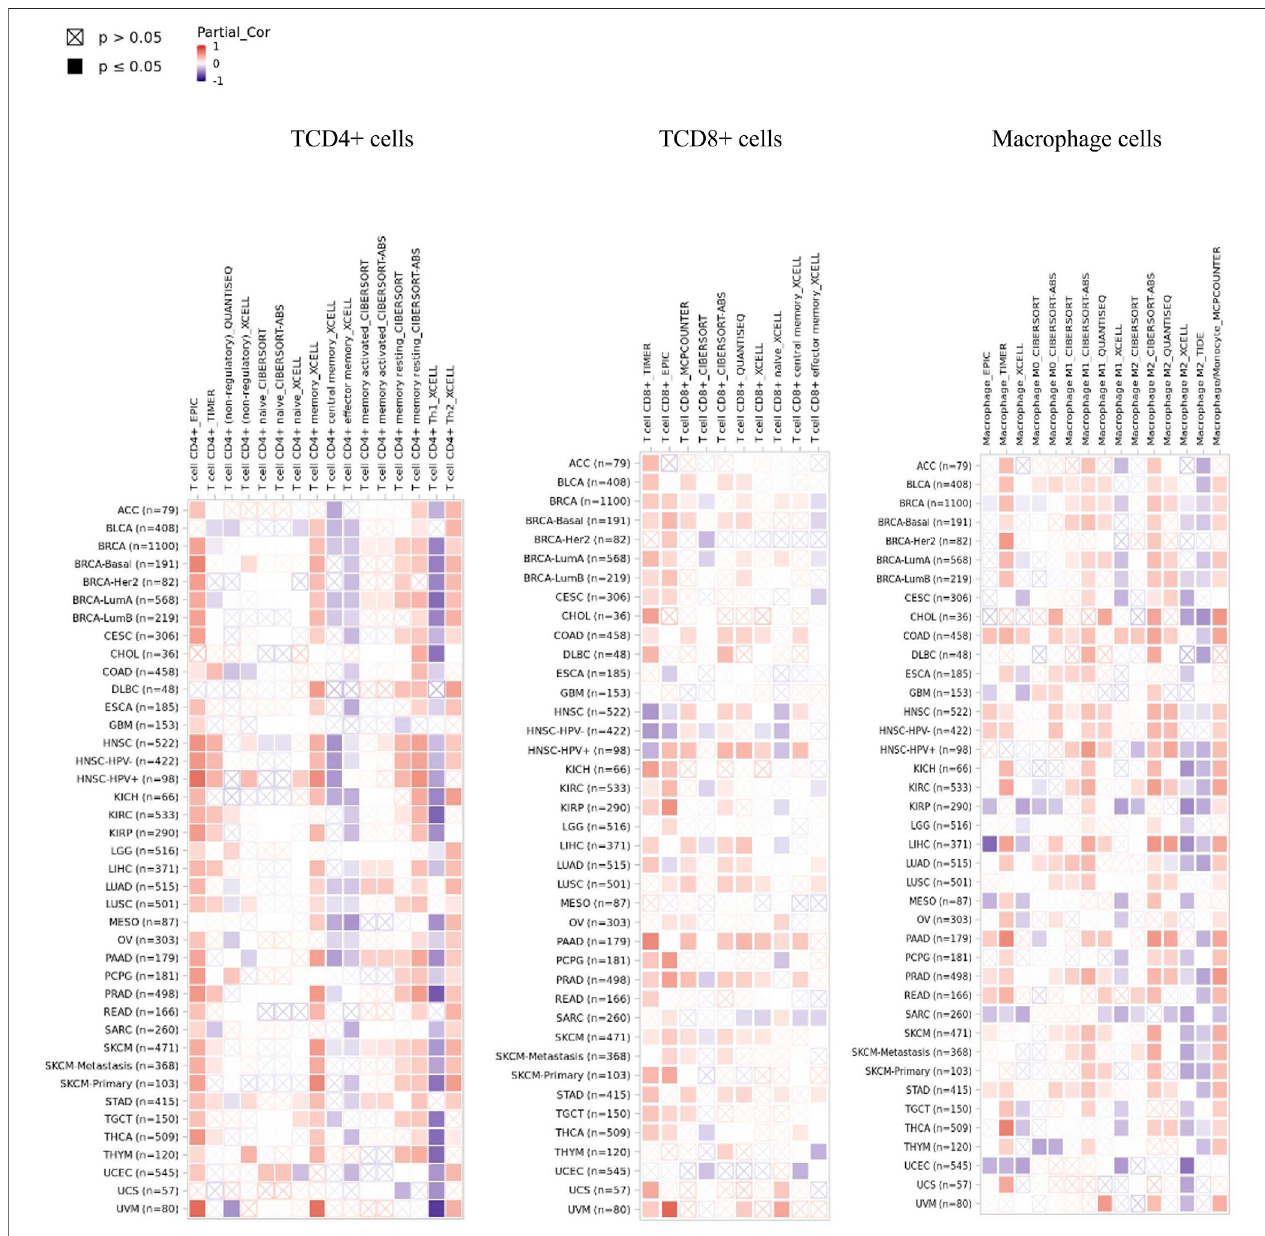
FIGURE 4 | Heatmap of immune cells with positive signi fi cant correlation with SENP1 in the Pan-Cancer cohort.